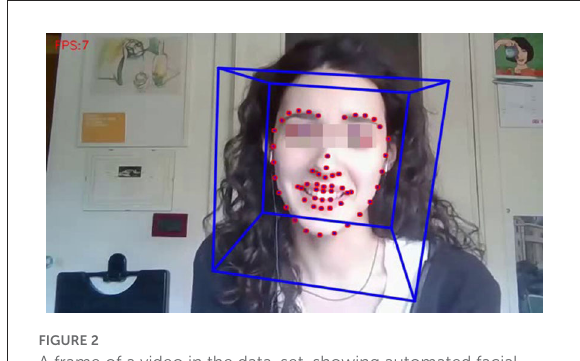
FIGURE2 A frame of a video in the data-set, showing automated facial features extraction through OpenFace.